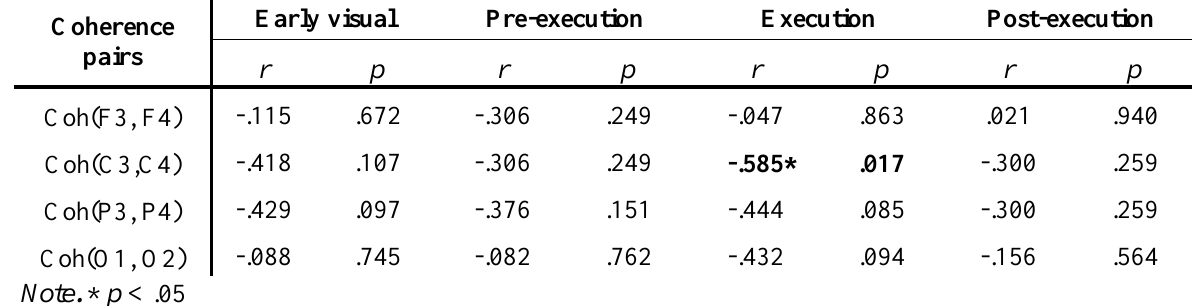
Table 7. Spearman’s r correlations between reaction time and the inter hemispheric coherence of combinations of channels in four phases. Only the pair of C3 C4 in the execution phase significantly correlated to reaction time (highlighted in